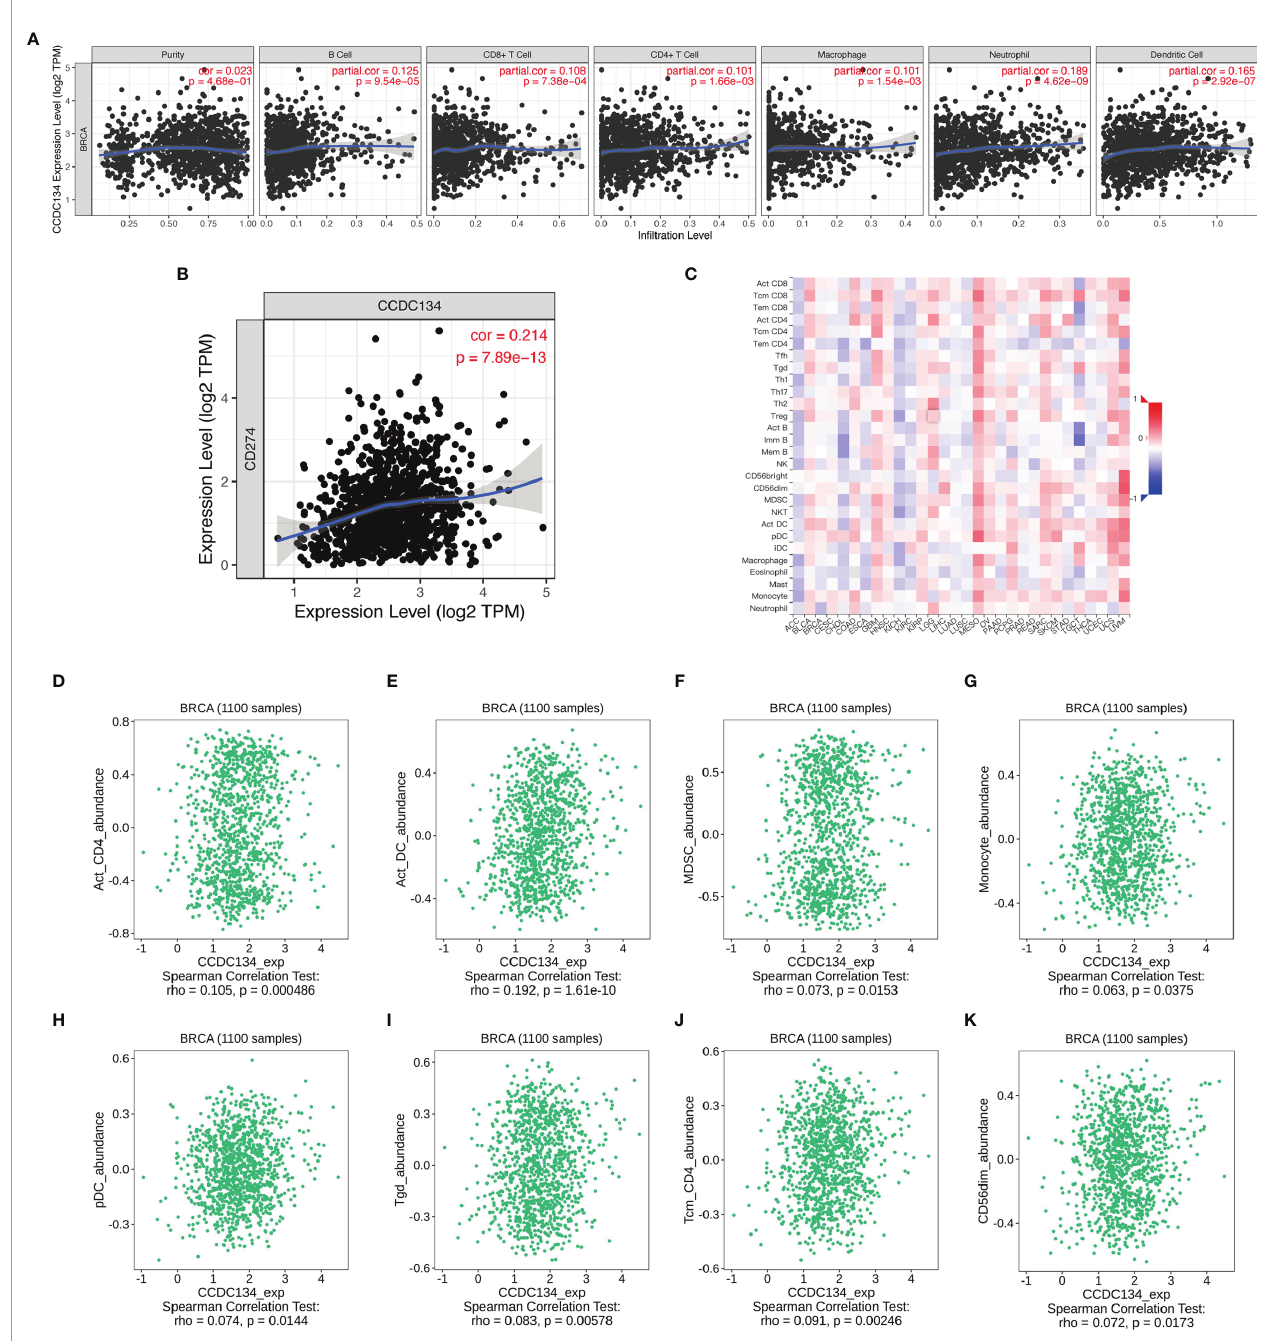
FIGURE 8 | CCDC134 expression and the immune level of correlation. (A) The expression of CCDC134 in breast cancer was correlated with tumor purity, B cells, CD4 + T cells, CD8 + T cells, macrophages, neutrophils and dendritic cells. (C) Relationship between CCDC134 expression and 28 lymphocyte species in human tumors. (B) CCDC134 expression was positively correlated with CD274(PD-L1) in breast cancer. (D – K) CCDC134 and CD4 + T cells (r= 0.105, P = 0.000486), DC cells (r= 0.192, P = 1.61E-10), MDSC cells (r= 0.073, P = 0.0153), monocytes (r = 0.063, P = 0.0375), pDC cells (r = 0.074, P = 0.0144), Tgd cells (r = 0.083, P = 0.00578), Tcm_CD4 + T cells (r= 0.091, P = 0.00246) and CD56DIM (r= 0.072, P =